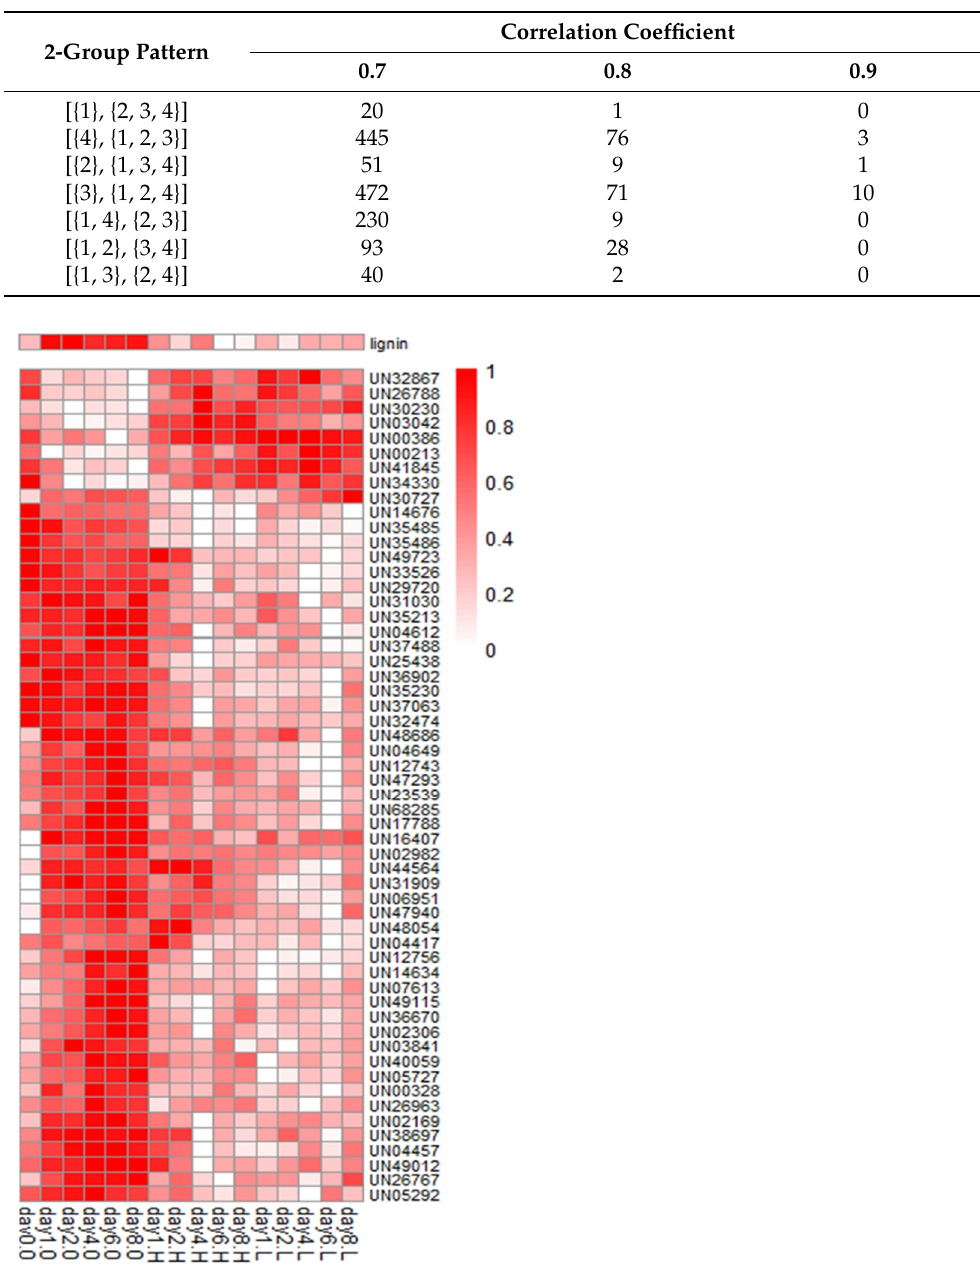
Table 1. The count of genes which highly correlated to lignin content in each of the seven 2-group patterns of phenotype data. The threshold of correlation coefficient was set as 0.7, 0.8 and 0.9.